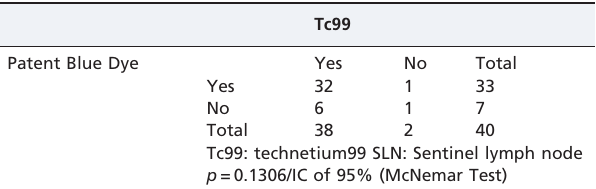
Table 5 - Identification of the SLN in the right and left cranial thoracic breasts of bitches when using technetium and patent blue (McNemar test).